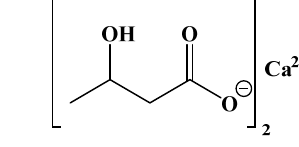
It has been shown in adult humans that daily administration of (R)-3-hydroxybutyl